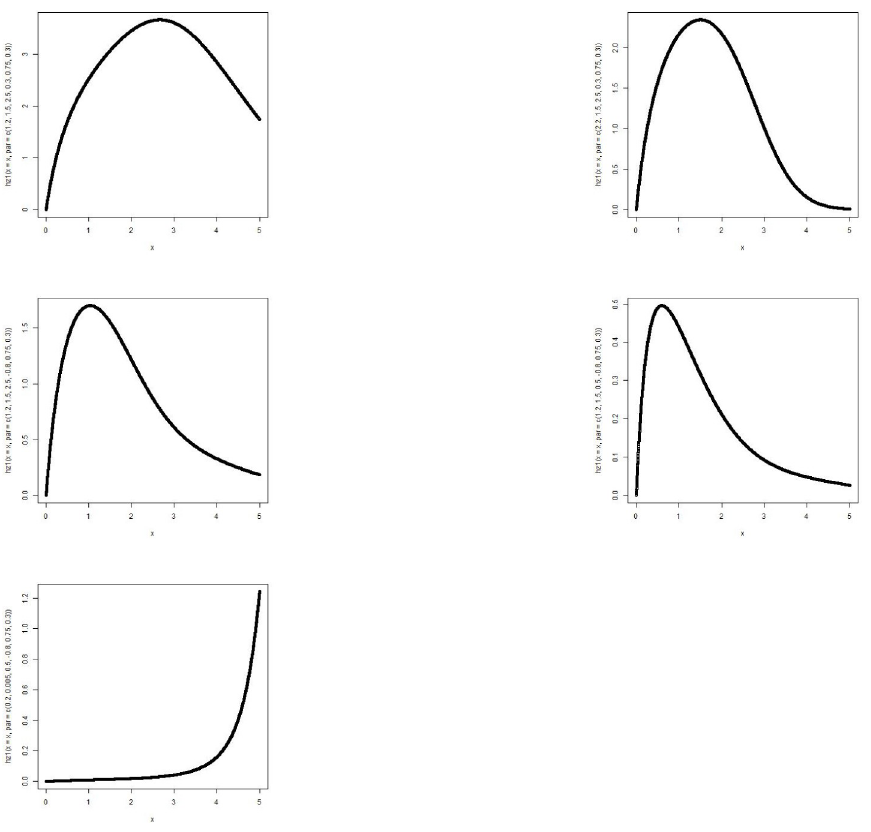
Fig 2. Graphs of hazard function of MBTGo with various parameter values.